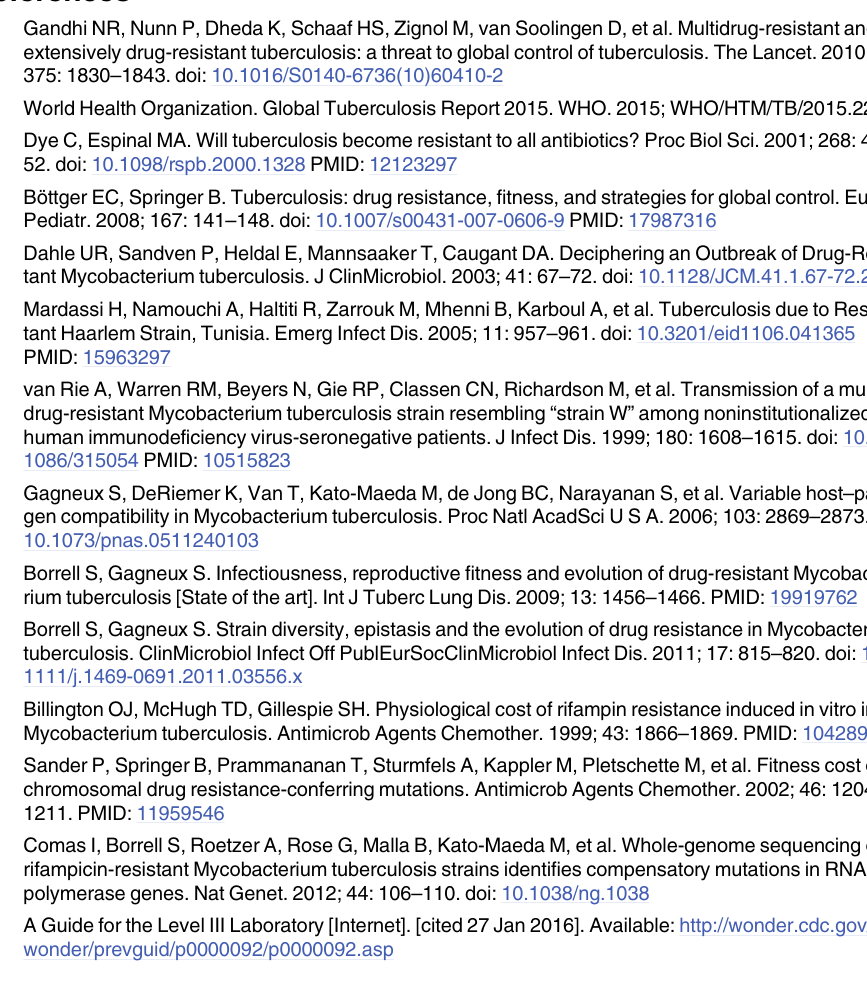
S2 Table. Characteristics of primers used to detect resistance mutations to first-line and second-line anti-tubercular